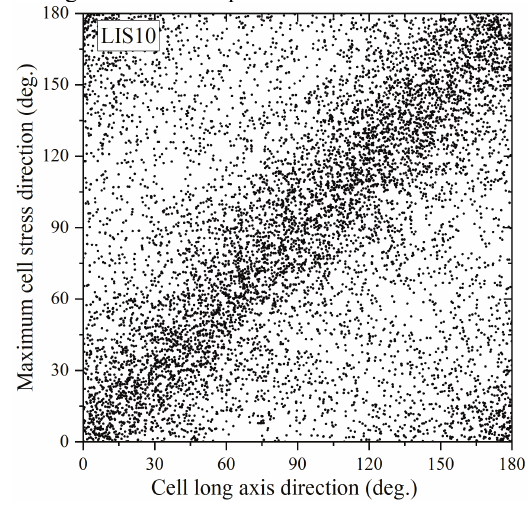
Fig. 10. Correlation between maximum cell stress direction and cell long axis direction